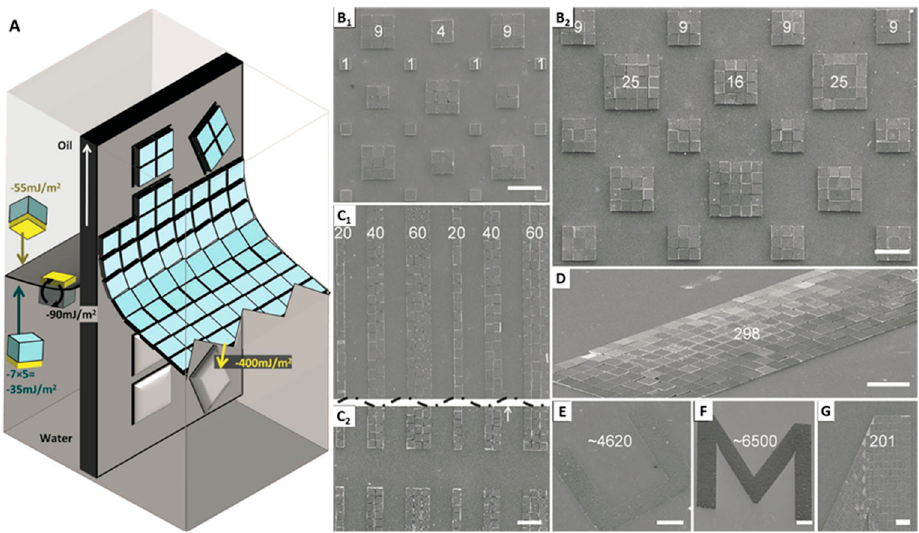
Figure 5. Strategy to assemble and connect chip-scale components with different dimensions, single-angular orientation, and contact-pad registration. ( A ) The available area and curved shape of the interface cause the components to form a closely packed 2D raft. Upward motion of the substrate yields a dynamic contact angle where the receding water layer becomes sufficiently thin for the gold to contact the solder domain, allowing the sections of the raft to transfer to the solder domain. Patterned transfer and self-assembly on molten solder is favored by 400 mJ/m 2 within this layer. SEM images of tiled domains of different size: Square domains with room for 1, 4, 9, 16, and 25 silicon tiles, 60 μ m on a side. 5 mm-long linear domains measuring 1, 2, and 3 component widths wide: ( C 1 ) center and ( C 2 ) end region. Rectangular domain with 300 Si-tiles ( D ), large letter-shaped domain for thousands of 20 μ m-wide SU-8 tiles ( E , F ). ( G ) Grain boundary in asymmetric elbow section of letter-shaped regions. Scale bars 180 μ m for ( A – G ) and 440 μ m for ( E , F ). Reprinted with permission from [41].